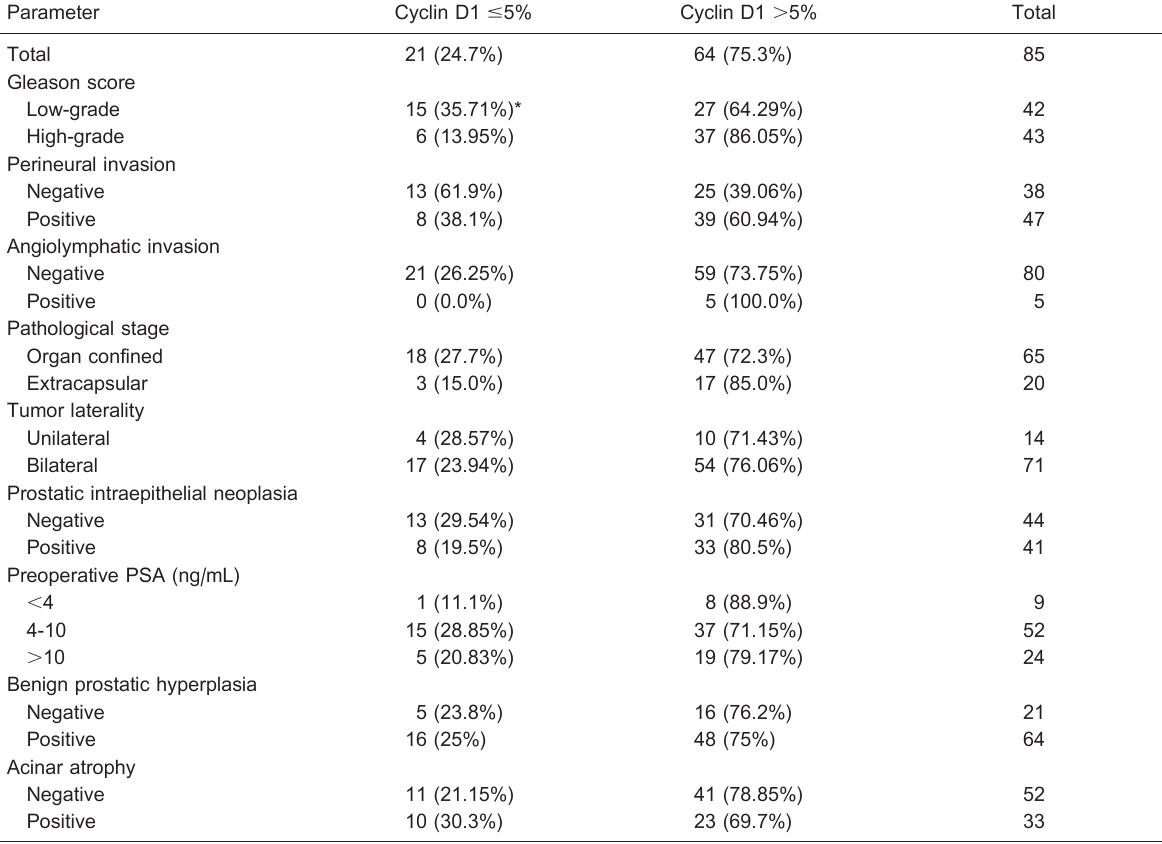
Table 1. Relationship between clinicopathological parameters and cyclin D1 expression in prostate